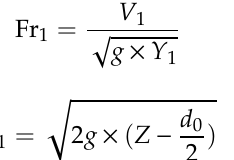
Figure 1. Laboratory flume and the experimental setup.